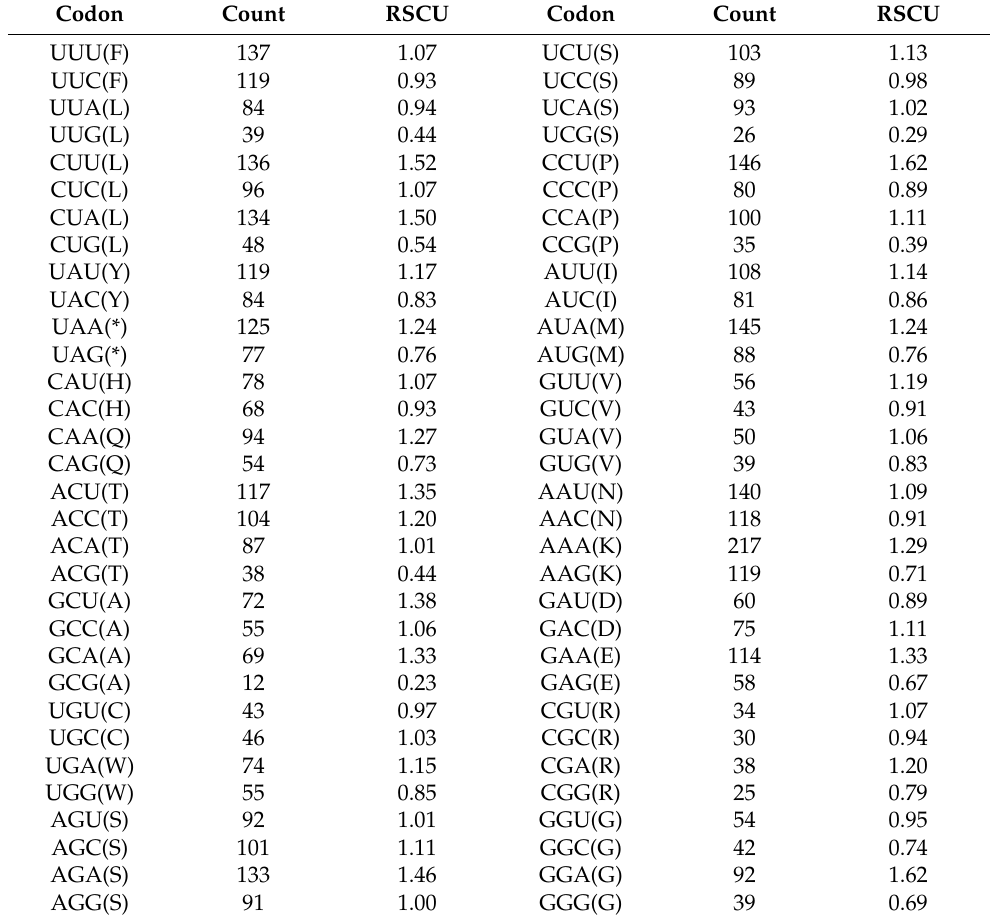
Table 4. Codon numbers and relative synonymous codon usage in the B. argus mitochondrial